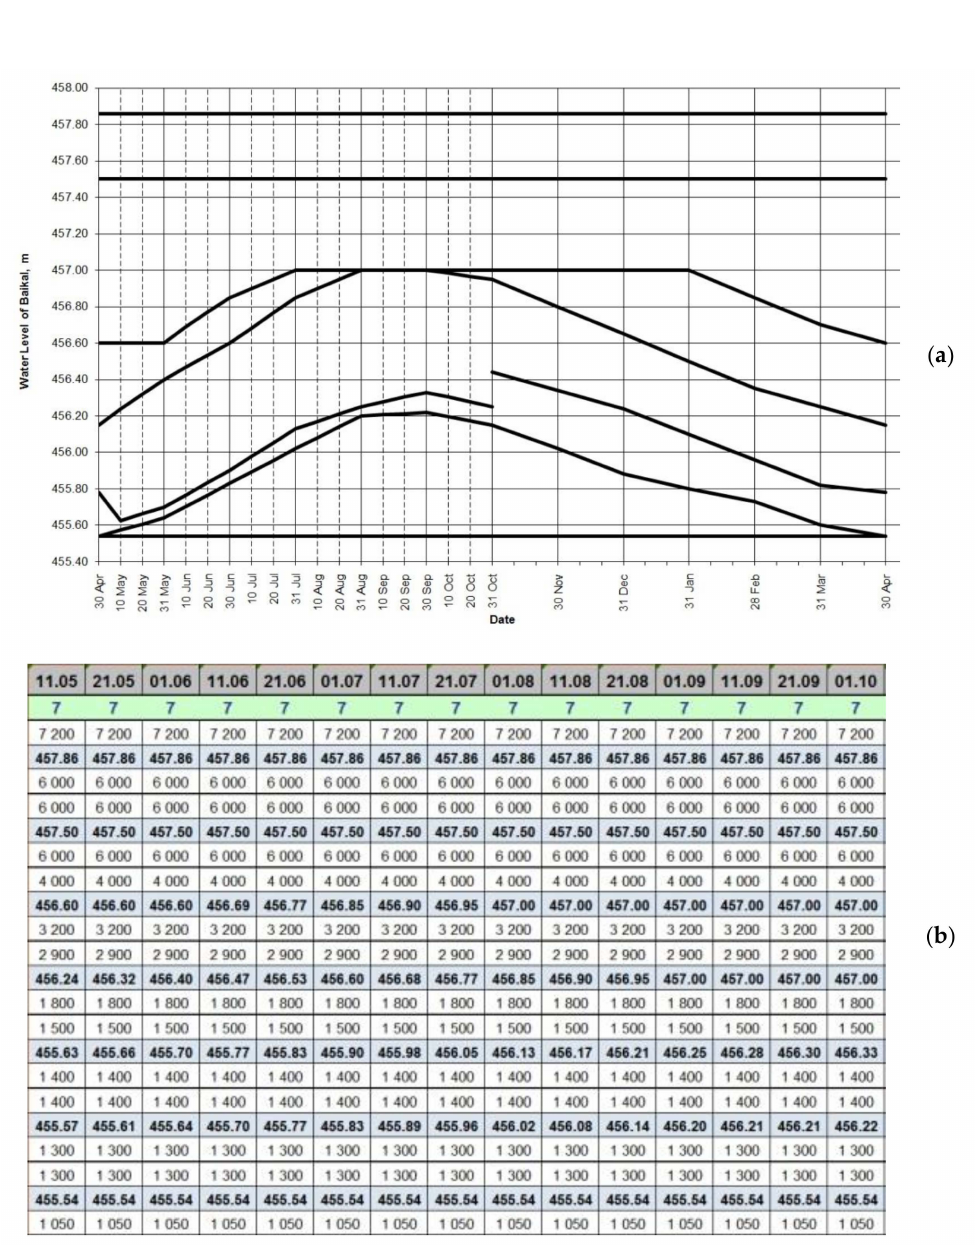
Figure 2. Shipment schedule for 1988 in graphic form ( a ) and fragment in tabular form ( b